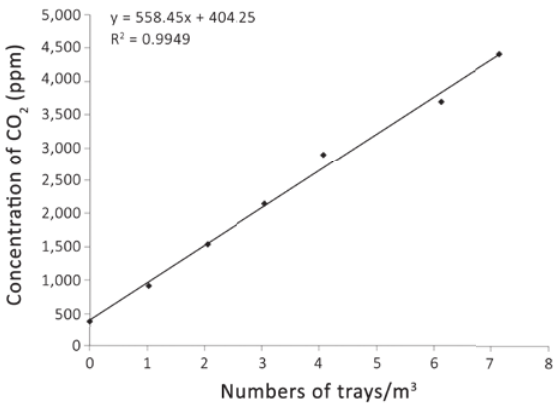
Figure 1 - Linear regression of CO 2 production at different densities of rearing trays of A. kuehniella (with approximately 10,000 larvae in the 5 th instar) per m 3 , 9.79 m 3 rooms, 25 ± 3°C, photophase: